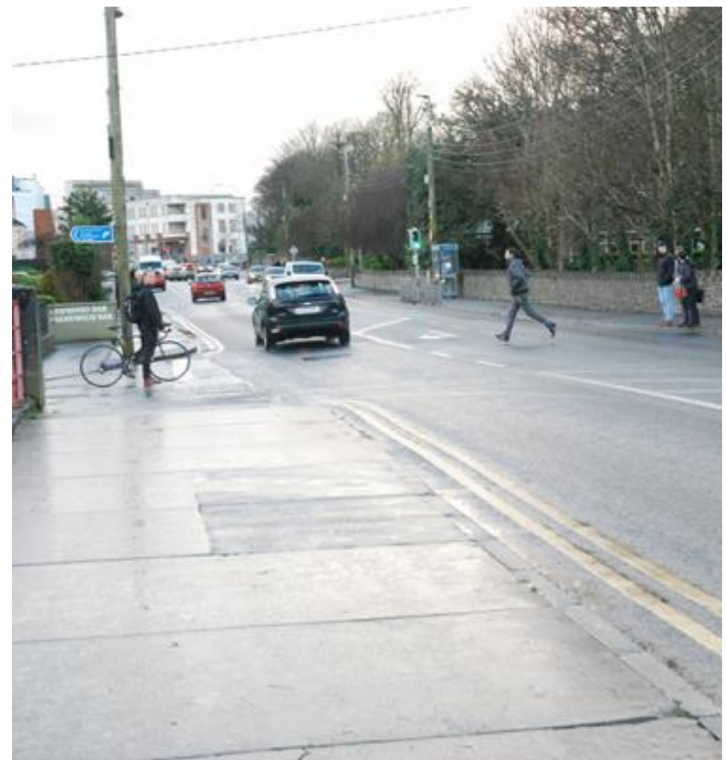
Figure 15. University Road,